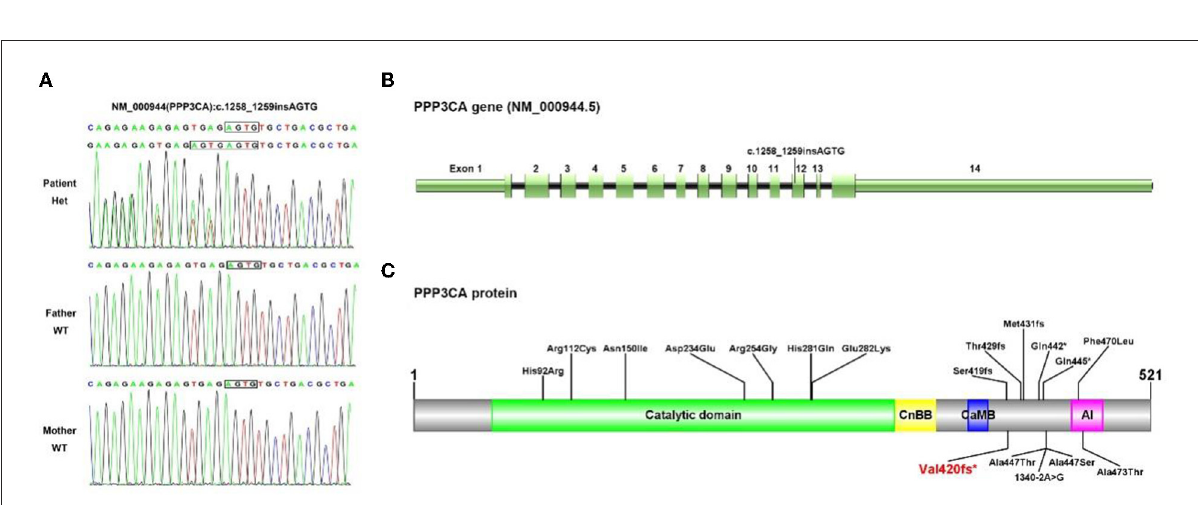
FIGURE2 EEG of the patient diagnosed with developmental and epileptic encephalopathy 91 at ages of 2 months (A) , 2 and a half months (B) , and one year and four months (C)